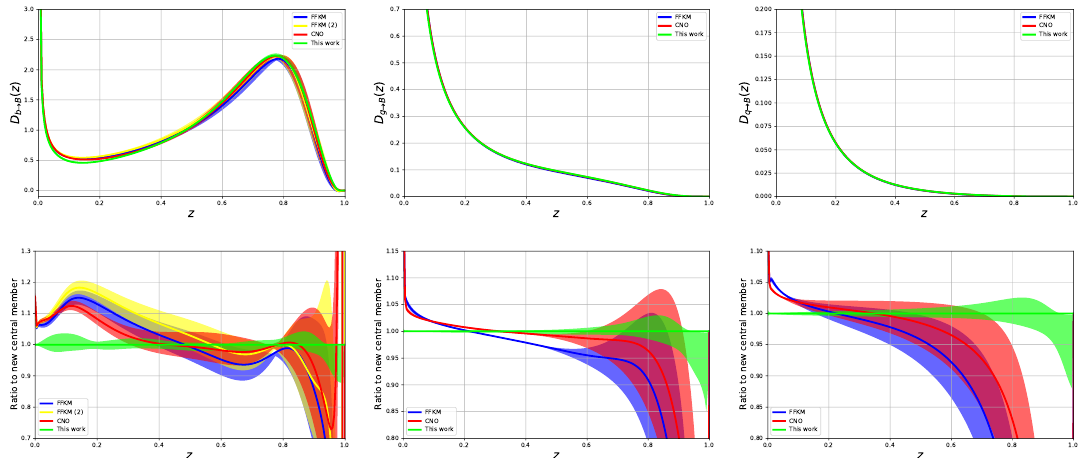
Figure 6 . A comparison of the new FF set (green) with the ones constructed in ref. [40] (yellow, blue and red), together with their uncertainties. From left to right: the b → B FF, the g → B FF and the q → B FF, where q can be any light quark. The top row shows the absolute plots, while the bottom plots show the ratios to the new FFs. The error bands are as in figure 5. The yellow curve is identical to the blue curve for both the gluon and the light-quark FFs, and is not shown in the corresponding plots. All curves are evaluated at µ = m Fr t